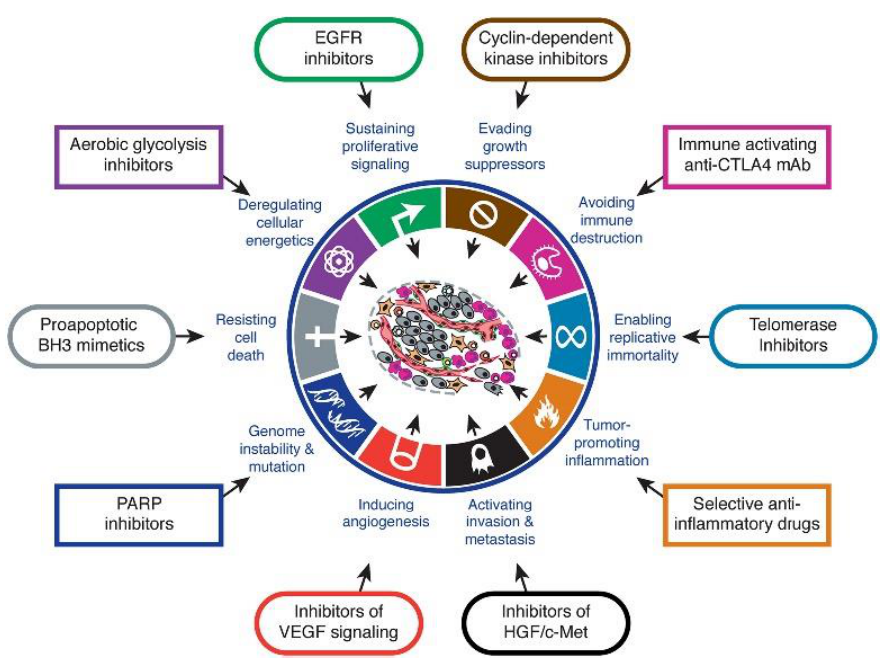
Figure 4. The hallmarks of cancer and their therapeutic targets. Reprinted with permission from Ref [65] . Copyright (2011) Elsevier Inc.